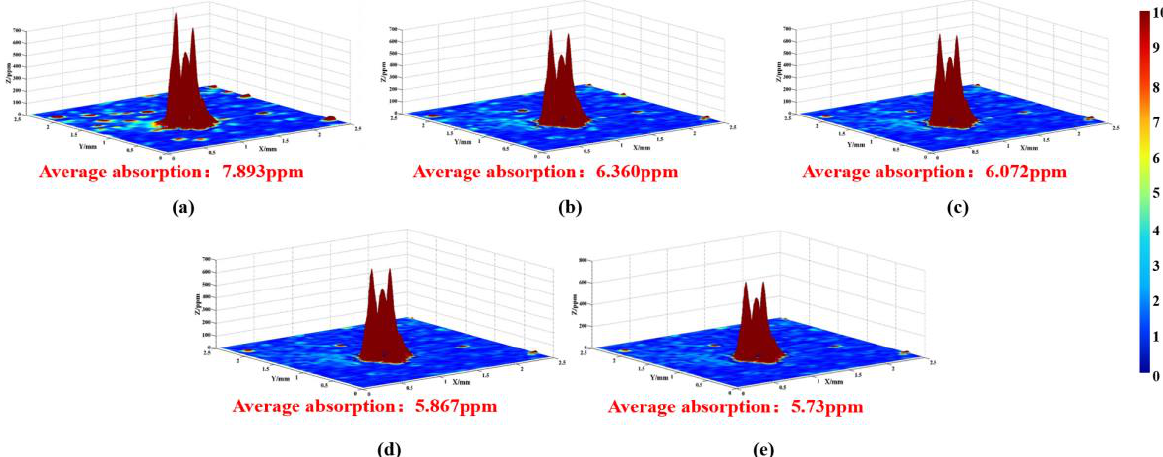
Figure 7. Photothermal absorption results after MRF process: ( a ) Material removal depth 0 μm; ( b ) Material removal depth 1.5 μm; ( c ) Material removal depth 3 μm; ( d ) Material removal depth 4.5 μm; ( e ) Material removal depth 6 μm.